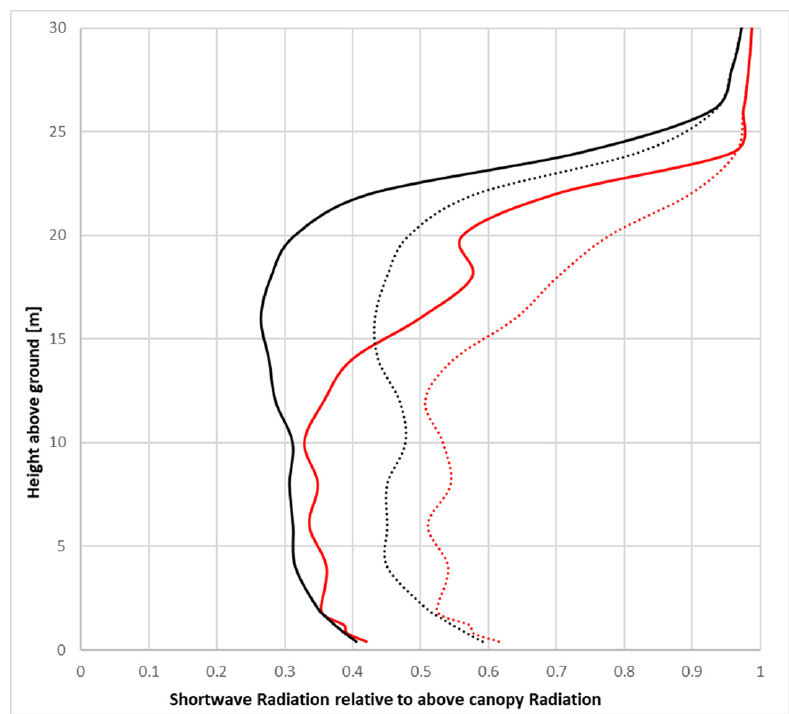
Figure 10. Vertical distribution of shortwave radiation through tree centerline at noon; red lines indicate L-Trees, black lines Parametric-Trees, dashed lines ACRT module o ff , solid lines ACRT on. Comparing these results with literature values for similar trees (regarding height and LAD), such as Balsam poplar in Mixlight where the authors compared predicted inner canopy radiation transmittance against measured values, shows that the simulation of the L-Tree with the ACRT module matches the measured and modelled values of Mixlight quite closely [27]. Other literature values of, e.g., Thakur and Kaur, 2001 [28] or Bartelink, 1998 [29] come to slightly lower ground level values of around 10% to 20%, however, featuring denser trees. Further direct comparison with literature values is constrained, as most studies are carried out on trees in forest stands instead of isolated locations [30,31]. To examine the e ff ect of both advancements onto the thermal comfort, the Physiological Equivalent Temperature (PET) underneath both trees has been calculated in a height of 1.4 m (Figure 11). The results show generally lower PET values in the ACRT including simulations of around 2 to 3.37 K for both trees. While the PET pattern underneath the parametric tree shows a more homogenous reduction of PET, the PET underneath the L-Tree is heterogeneously distributed as the non-uniform LAD clusters of the L-Tree cause di ff erent levels of shading and thus mean radiant